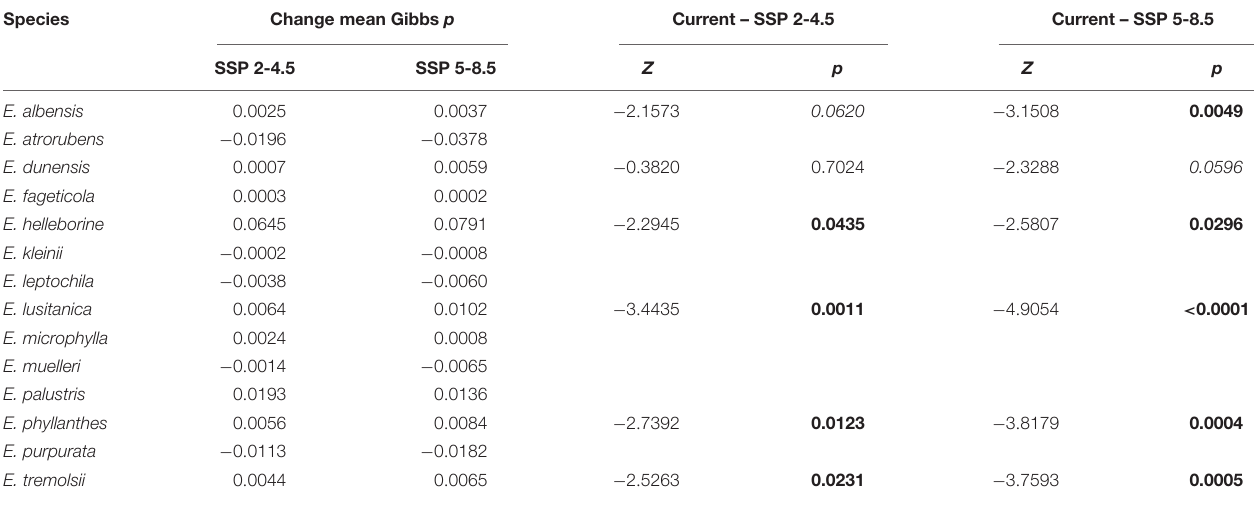
TABLE 1 | Change in mean Gibbs values (habitat suitability) for Epipactis species from current to future (2061–2080) climate scenarios (SSP 2-4.5 and SSP 5-8.5) and results of Dunn tests comparing current and future mean Gibbs p -values (showing only results for significant differences, in bold, and marginally significant differences, in